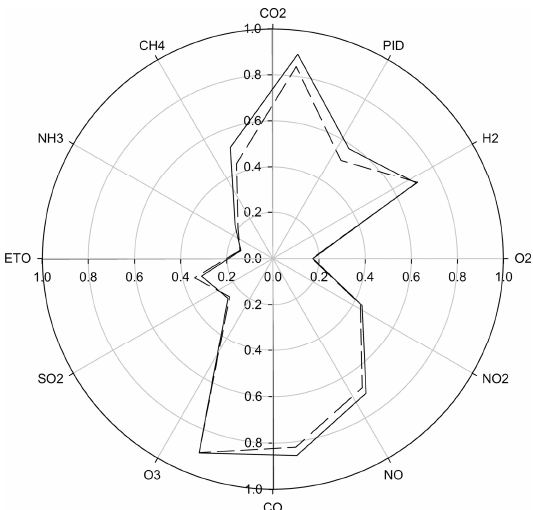
Figure 6. Radial plot of the average normalized response of all 13 Warwick Olfaction System (WOLF) sensors to CRC (full line) and IBS (dashed line) urine samples. Used with permission from [45].